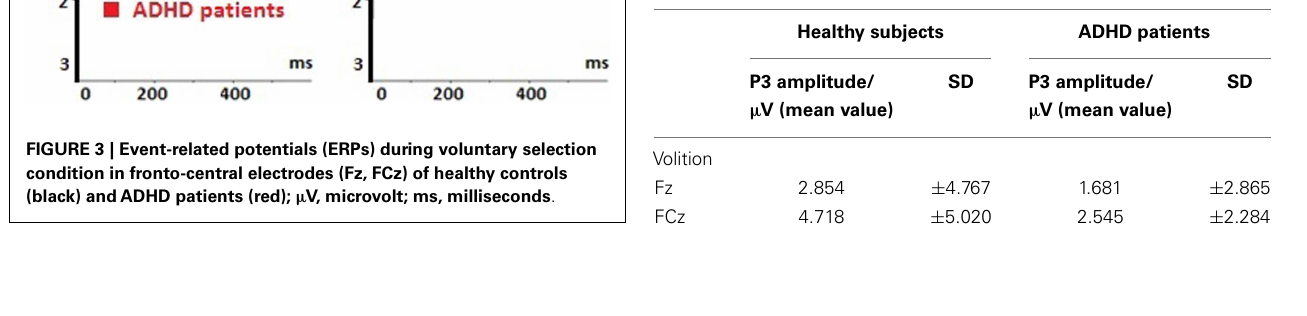
Table 2 | P3 amplitudes during voluntary selection measured at different central